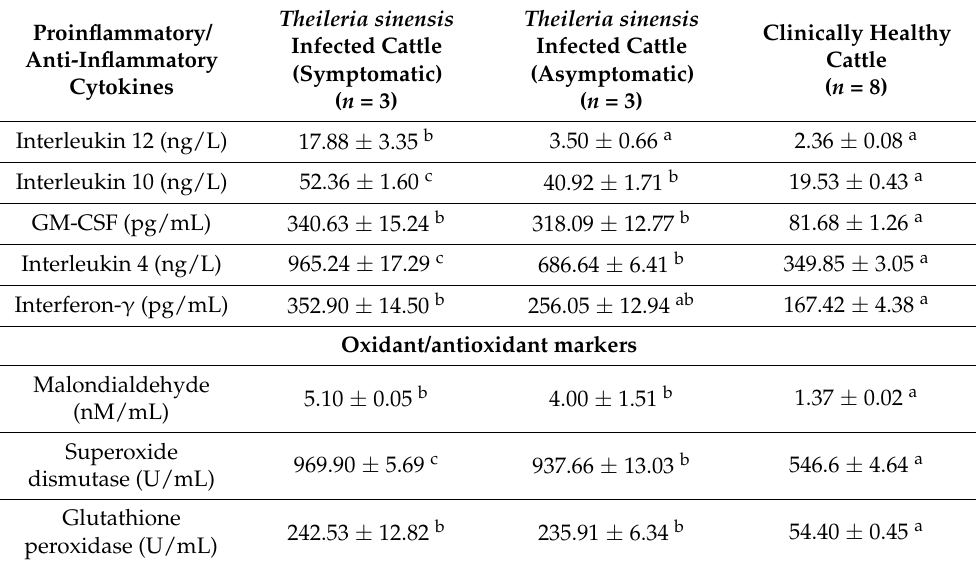
Table 6. The serum inflammatory cytokines and oxidant/antioxidant levels in symptomatic and asymptomatic cattle naturally infected with Theileria sinensis